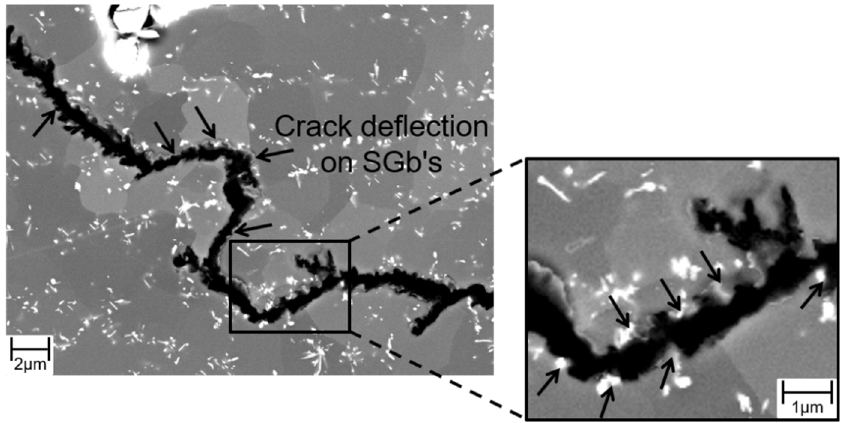
Figure 13. SEM micrographs of crack deflection at Laves phase particle covered sub-grain boundaries in precipitation-annealed (PA) Crofer ® 22H.